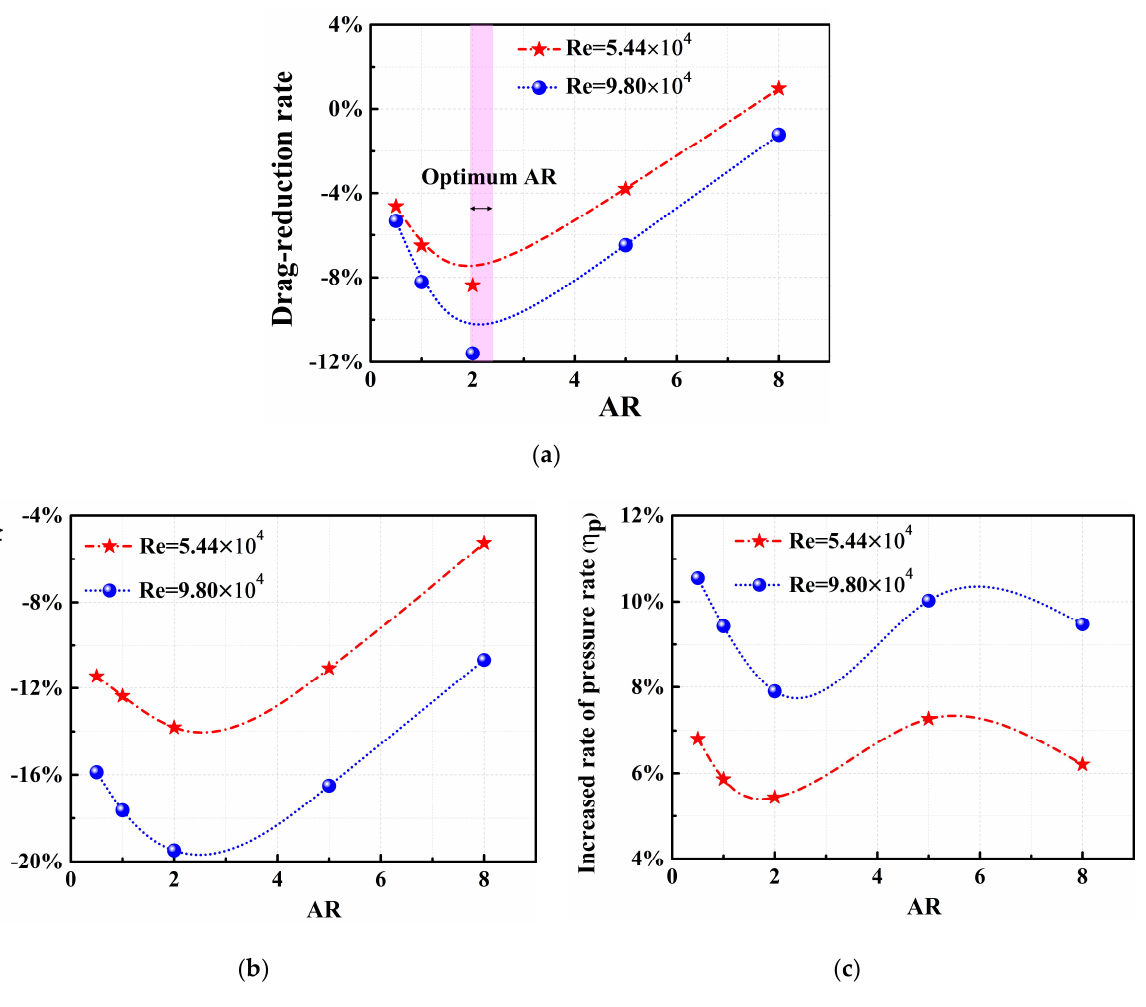
Figure 23. Drag-reduction rate varies with AR. ( a ) Total drag-reduction rate; ( b ) reduction rate of viscous drag; ( c ) increased rate of pressure drag.